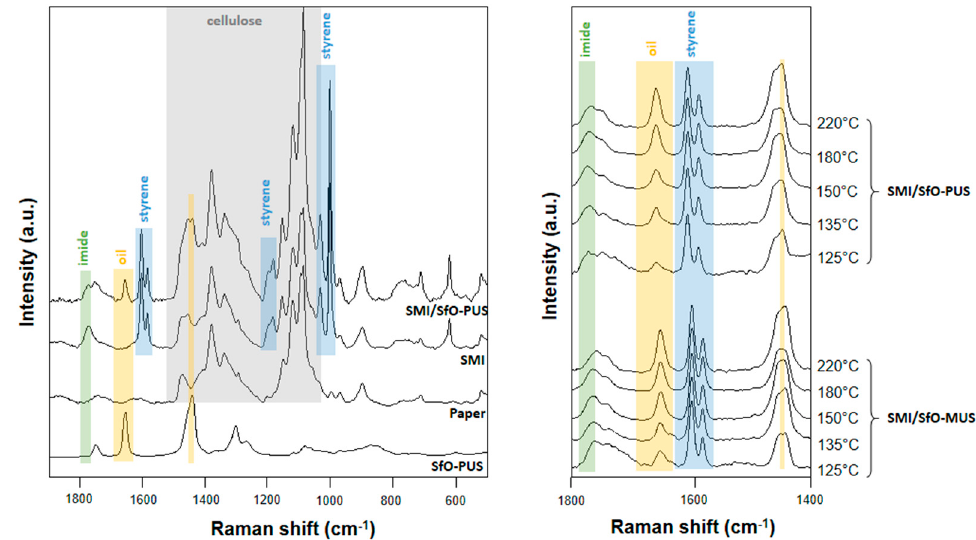
Figure 5. Single-point Raman spectra for SMI/SfO-PUS and SMI/SfO-MUS coatings together with reference materials, and after thermal release of oil at different temperatures.